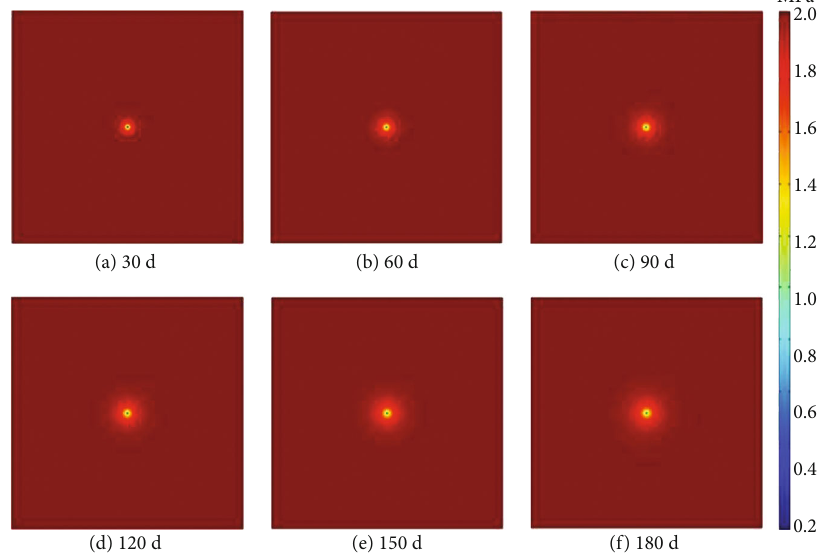
Figure 15: Distributions of gas pressure at varying gas extraction times before unloading